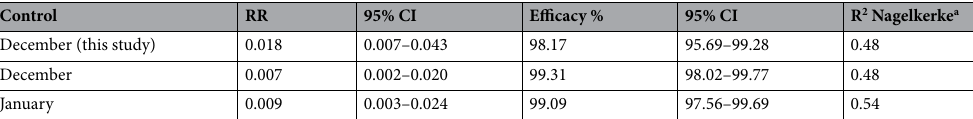
Table 2. Overall relative risk ratios (RR) and efficacy of the laser to reduce wild birds visits. a These measures indicate the overall performance of the generalized linear models; (negative binomial distributions) used to quantify the RR and Efficacy.